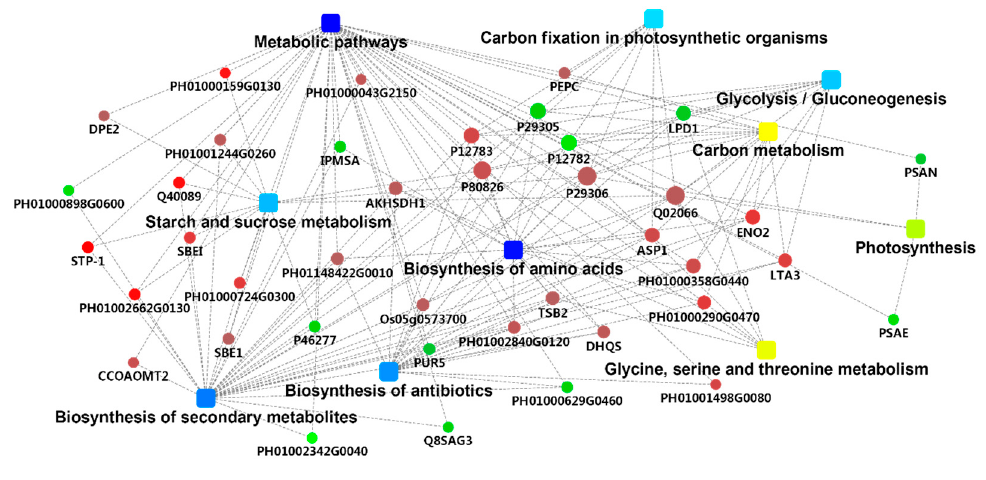
Figure 4. Protein-protein interaction ( PPI) network map of the differentially expressed proteins in the B. pervariabilis × D. grandis between the induced group and the control group. Round nodes represent proteins/genes (for fold change analysis, red shows up-regulation and green shows down-regulation). Rectangular nodes represent KEGG pathways/biological processes. A significant p value is represented by a yellow–blue gradient, where yellow indicates a small p value and blue indicates a large p value. Table 2. Differentially expressed protein information for high connectivity in the PPI analysis.